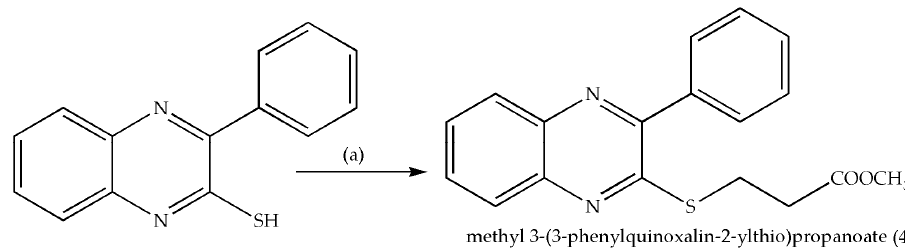
Scheme 14. Synthetic pathway to prepare S-alkylation of phenyl quinoxaline-2(1 H )-thione ( 47 ) with reagents and conditions: ( a ) triethylamine/ethanol/reflux/78 °C/CH 2 =CHCOOC 2 H 5 .